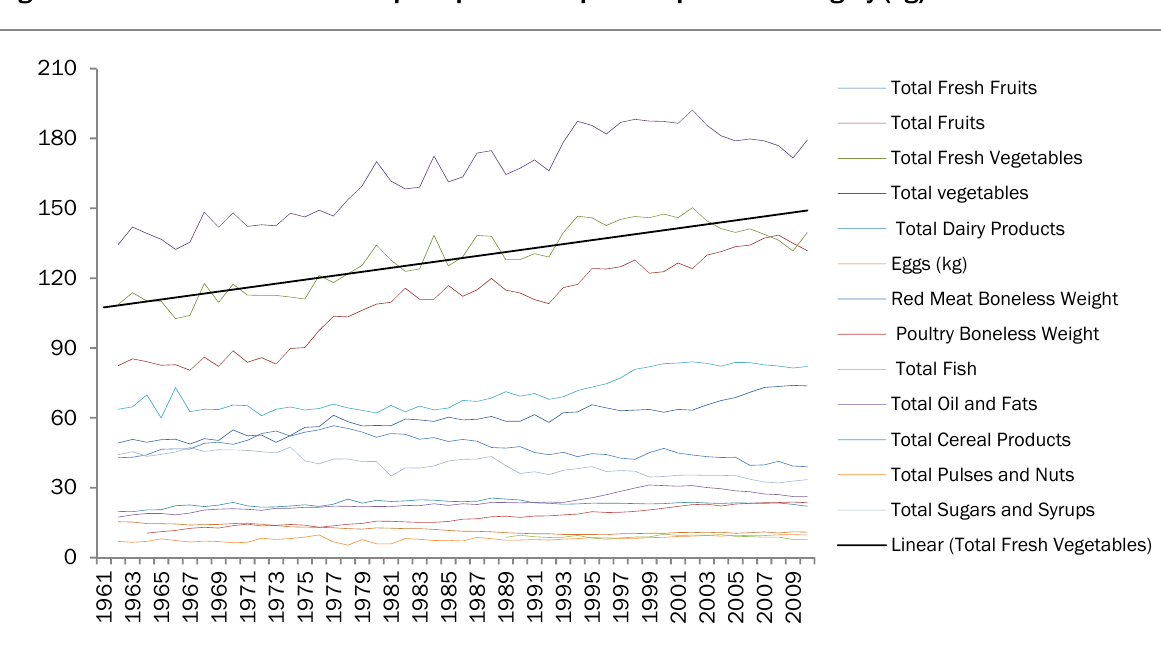
Figure 3. Available Food for Consumption per Person per Year per Food Category (kg)